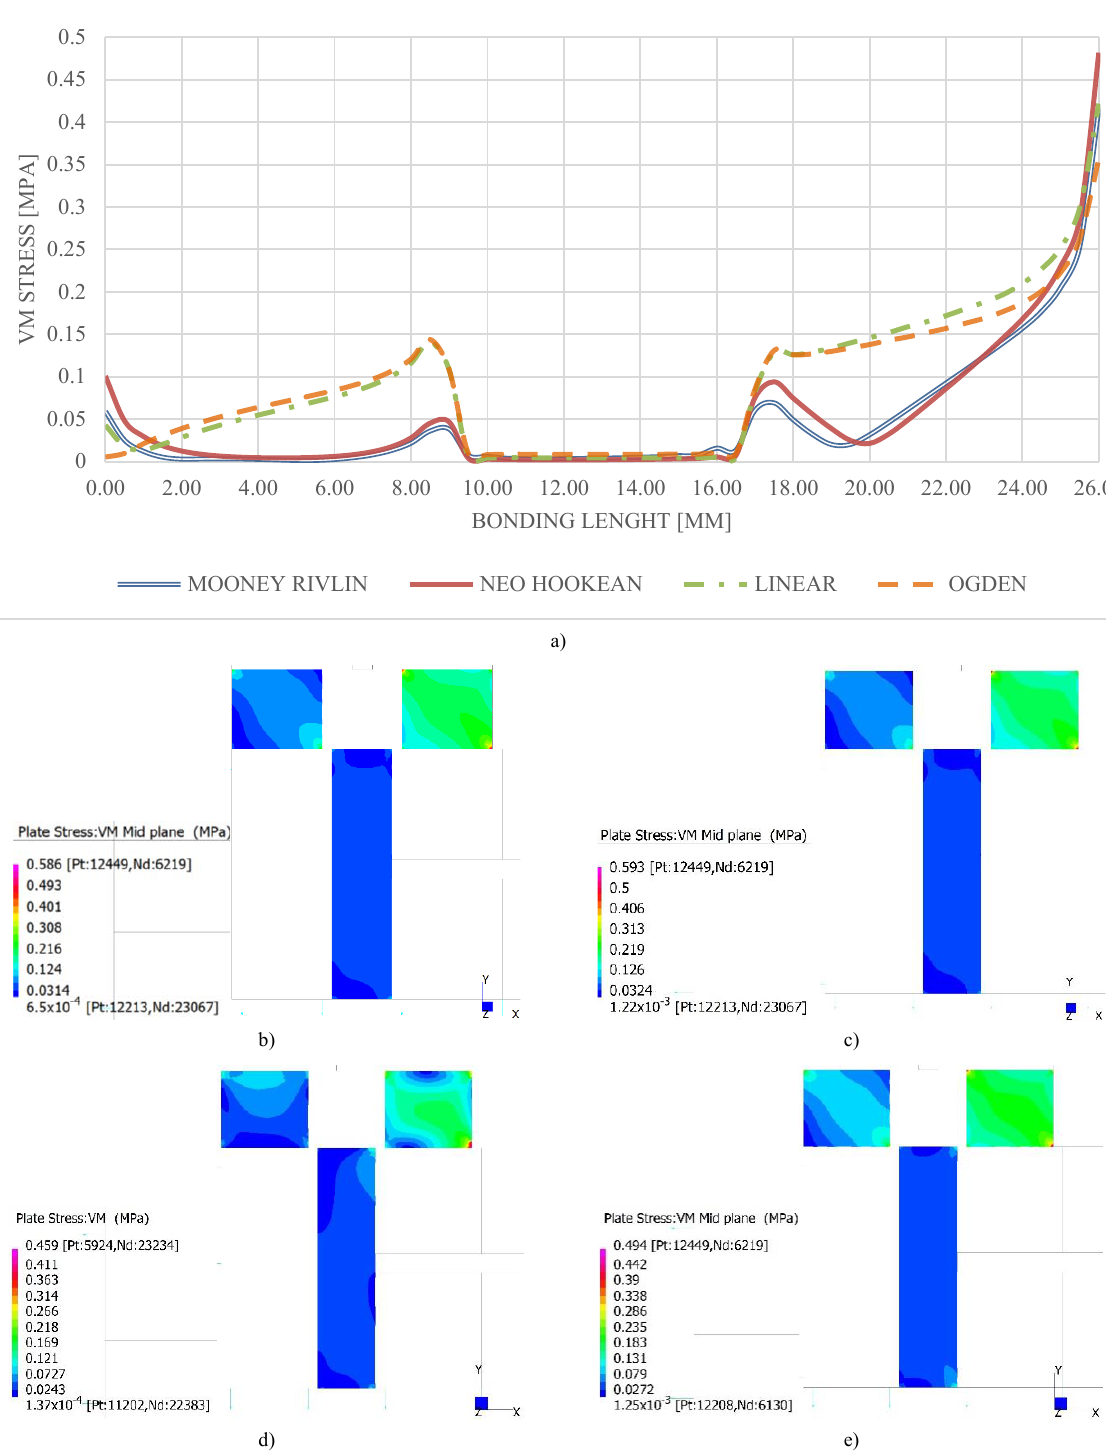
Fig. 10 Von Misses stress analysis in joint. a) Comparison graph cut line at bottom glass interface, b) Linear elastic material model, c) Neo- Hookean material model, c) Mooney Rivlin material model and d) Ogden material